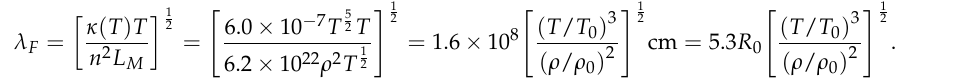
Figure 6a,b show the distribution of the Field length λ F / R 0 of Model 2 at t / t 0 = 10 and t / t 0 = 30, respectively. In the coronal region at t / t 0 = 10, since the Field length is longer than the size of the simulation region, thermal conduction dominates radiative cooling. However, in the region r > z , since radiative cooling becomes dominant over heat conduction, hot accretion flows can condensate by the cooling instability. On the other hand, thermal conduction suppresses the cooling instability in the intermediate region at t / t 0 =